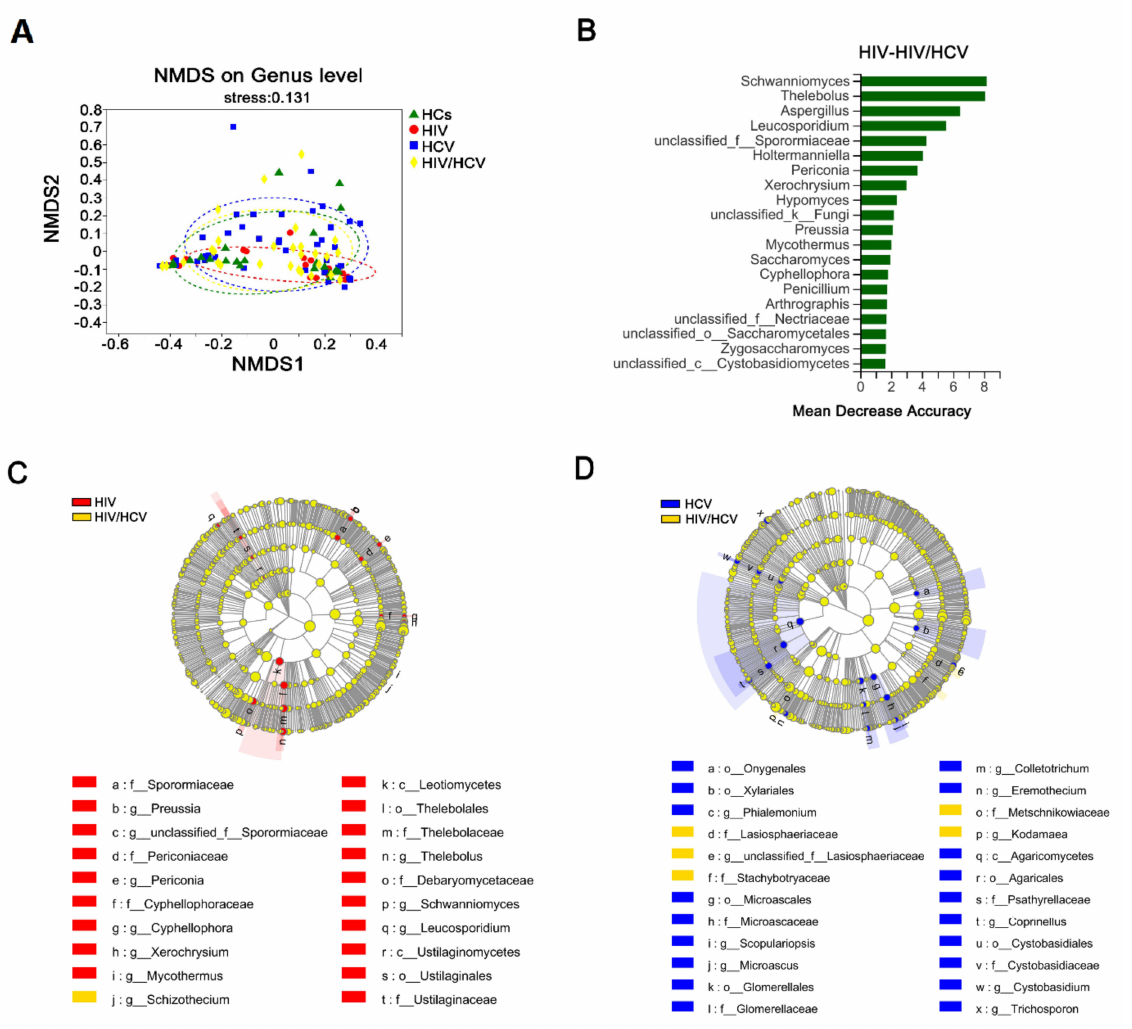
Figure 6. Differences in the gut mycobiome between mono-infected groups co-infected group. ( A ) Fungal β -diversity (NMDS-based Bray–Curtis distance matrix) between the four groups at genus level. ( B ) Random forest graph showing the 20 most predictive fungal genera between HIV mono-infection and HIV/HCV co-infection patients. ( C , D ) show the LEfSe discriminant cladograms between the HIV or HCV mono-infection and co-infection groups (LDA=